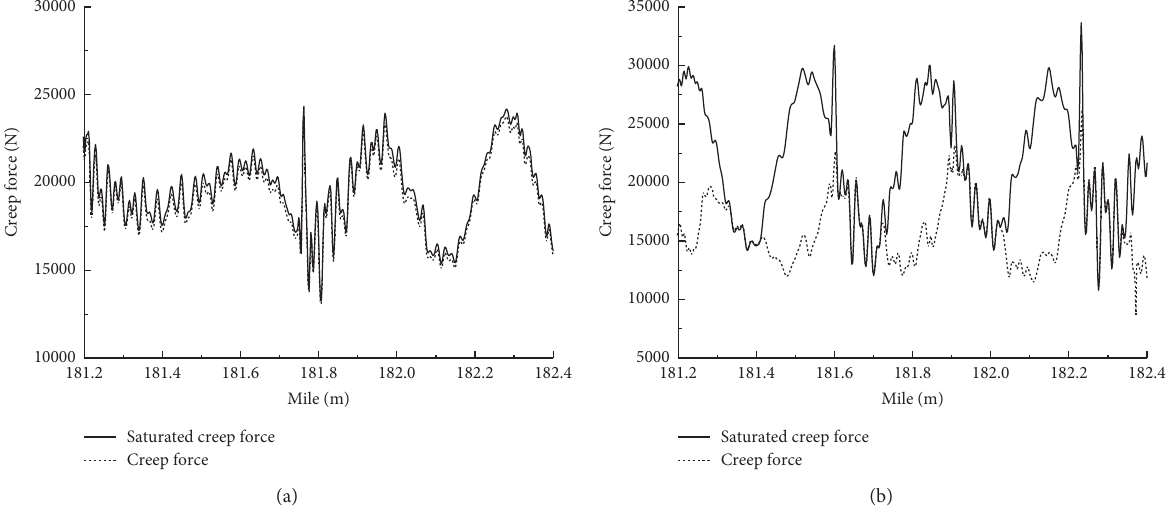
Figure 5: Creep force and saturated creep force. (a) Outer rail. (b) Inner rail.